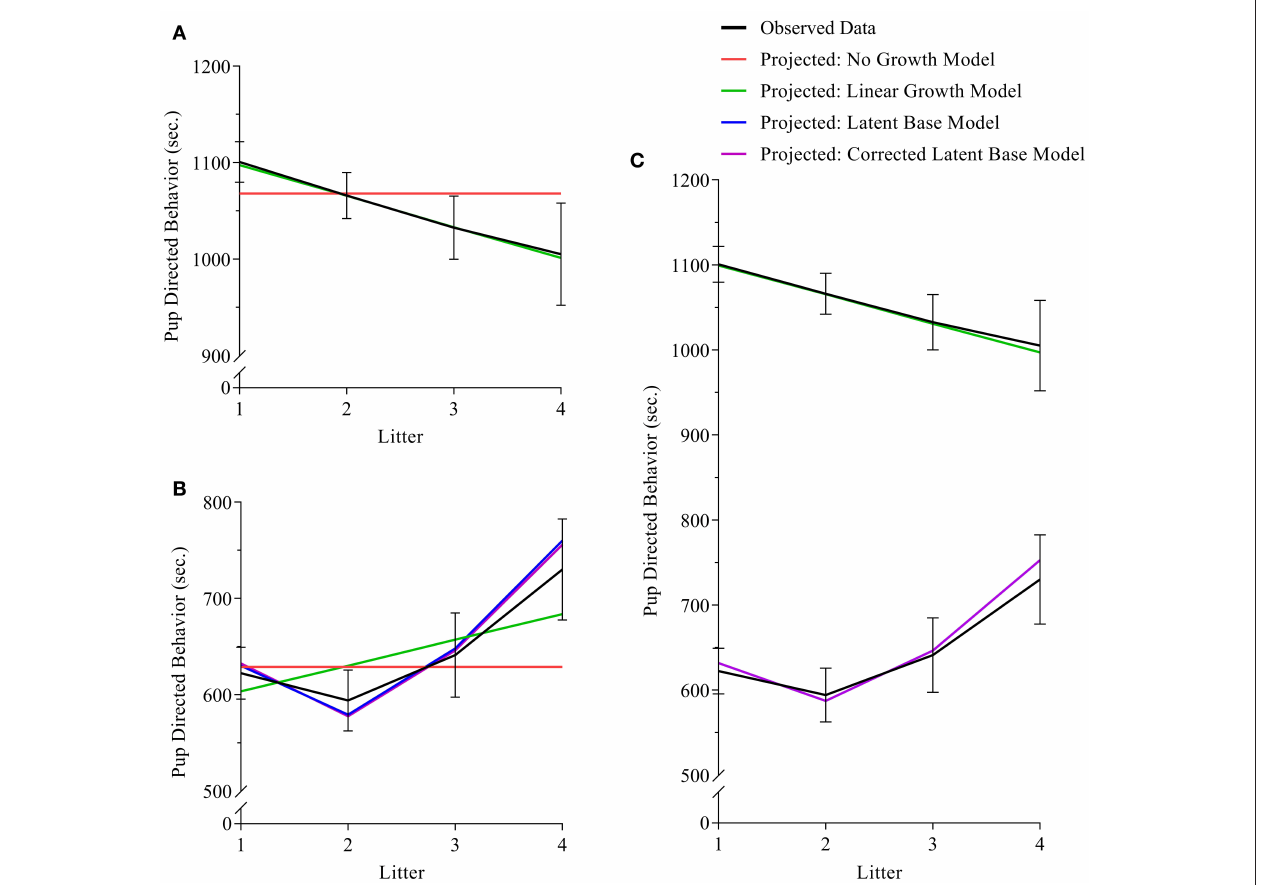
FIGURE 3 | (A–C) (A) maternal, (B) paternal, and (C) bivariate dyadic models of pup-directed behavior. In all sub-figures: black lines indicate the plotted means of the sample data; red lines indicated the plotted means of the calculated no-growth model; green lines indicate the plotted means of the calculated linear model; blue and purple lines indicate the plotted means of the uncorrected and corrected latent base models, respectively. In Figure 1C , the black line in the lower half of the figure indicates the means of sample data for fathers, and the black line in the upper half of the figure indicates the means of sample data for mothers. Black error bars represent standard